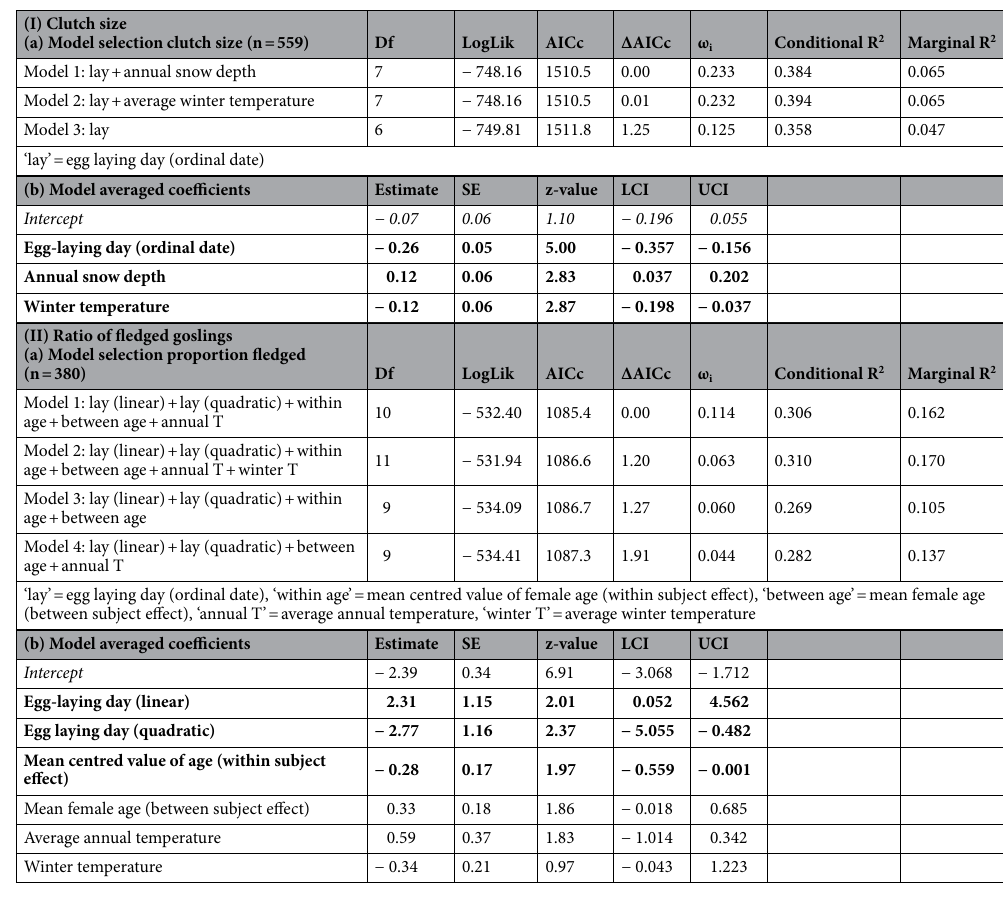
Table 4. (I) Linear mixed effects model for clutch size; and (II) generalized linear mixed effects model for the ratio of fledged goslings (binomial distribution with log-link function) over 29 years (1990–2018) in the Alm valley in relation to the timing of breeding, female breeding age, and weather. (a) Model selection table with competing models considering different weather predictors compared by Akaike’s Information Criterion for small samples (AICc) against each other and model weight (ω i ); and (b) Model-averaged coefficients from a set of 3 models for clutch size; and, from a set of 4 models ratio of fledged goslings with ΔAICc < 2.0 presented as estimated values ± (unconditional) SE, lower and upper 95% CIs; confidence intervals of parameter estimates not including zero (i.e., considered significant) are displayed in bold. Note that all quantitative input variables were scaled and centred; (I) Null model ranked 59th [Akaike’s information criterion corrected for small sample size (AICc) = 1528.6, ΔAICc = 18.07]; Note that in the clutch size model selection, we did not include ‘year’ as random intercept (throughout) because the variable caused singularity and explained 0% of the variance, which means that the fitted linear mixed model is very close to being a linear model (as indicated by comparing the lmer() model output with the lm(), results are very similar). In such cases the random term should be removed 119 . (II) Null model ranked 73rd AICc = 1100.2, ΔAICc = 14.82]; model weight based on complete list of candidate models (n =